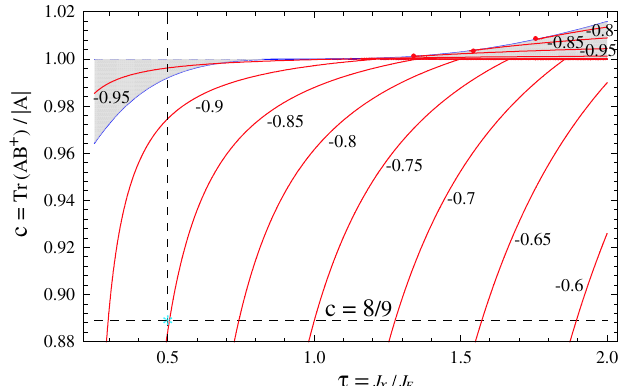
FIG. 5. (Color) Contours of optimal q (red curves) for minimum effective emittance over the (cid:12) - c parameter space. The gray (white) area shows the region with positive (negative) discrimi- nant for the cubic equation. Only one of the three roots in the gray area is a suitable ¼